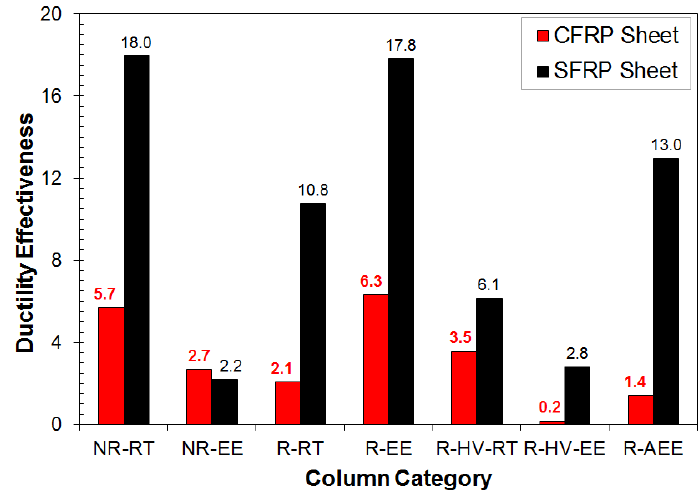
Figure 6. Ductility effectiveness of the SFRP and CFRP wrapped concrete